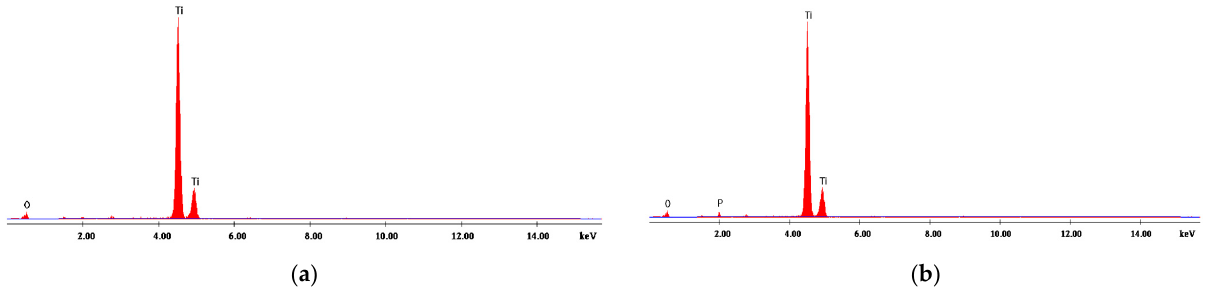
Figure 3. EDX analysis of titanium dioxide ( a ) before and ( b ) after phosphorus adsorption.